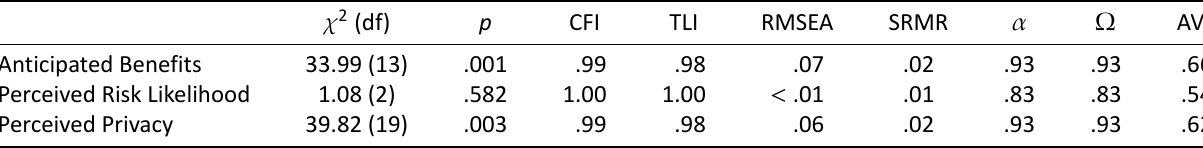
Table 1. Results of the confirmatory factor analyses with fit indices. Internal consistency (Cronbach’s 𝛼 , composite reliability (MacDonald’s Ω ), and average variance extracted) of the assessed